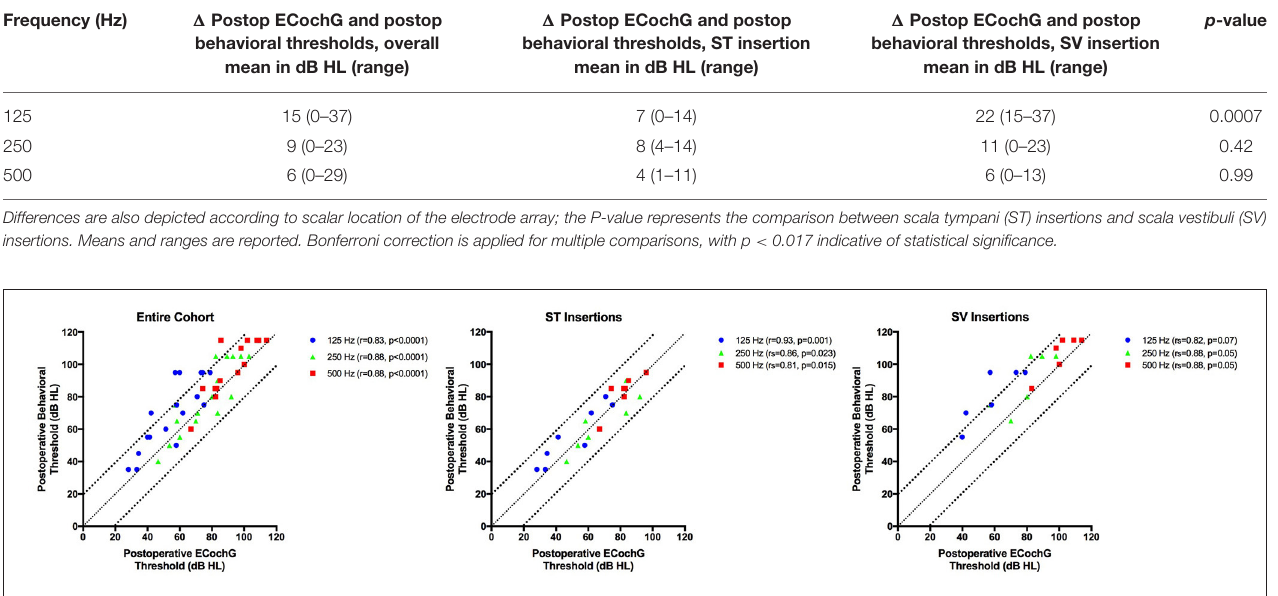
FIGURE 4 | The relationship between postoperative ECochG thresholds and postoperative behavioral thresholds for 125, 250, and 500Hz frequencies are depicted in the entire cohort, and for those cases in which scalar location is known. Bonferroni correction is applied for multiple comparisons, with p < 0.017 indicative of statistical significance.